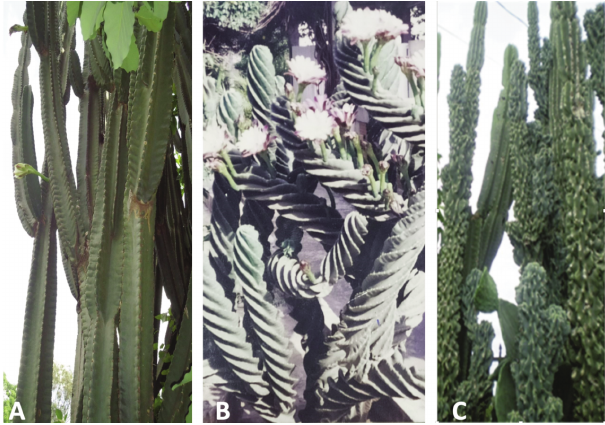
Fig. 1 ­ Different morphologies of Cereus peruvianus plants showing stems: erect (A), tortuosus (B), monstruosus